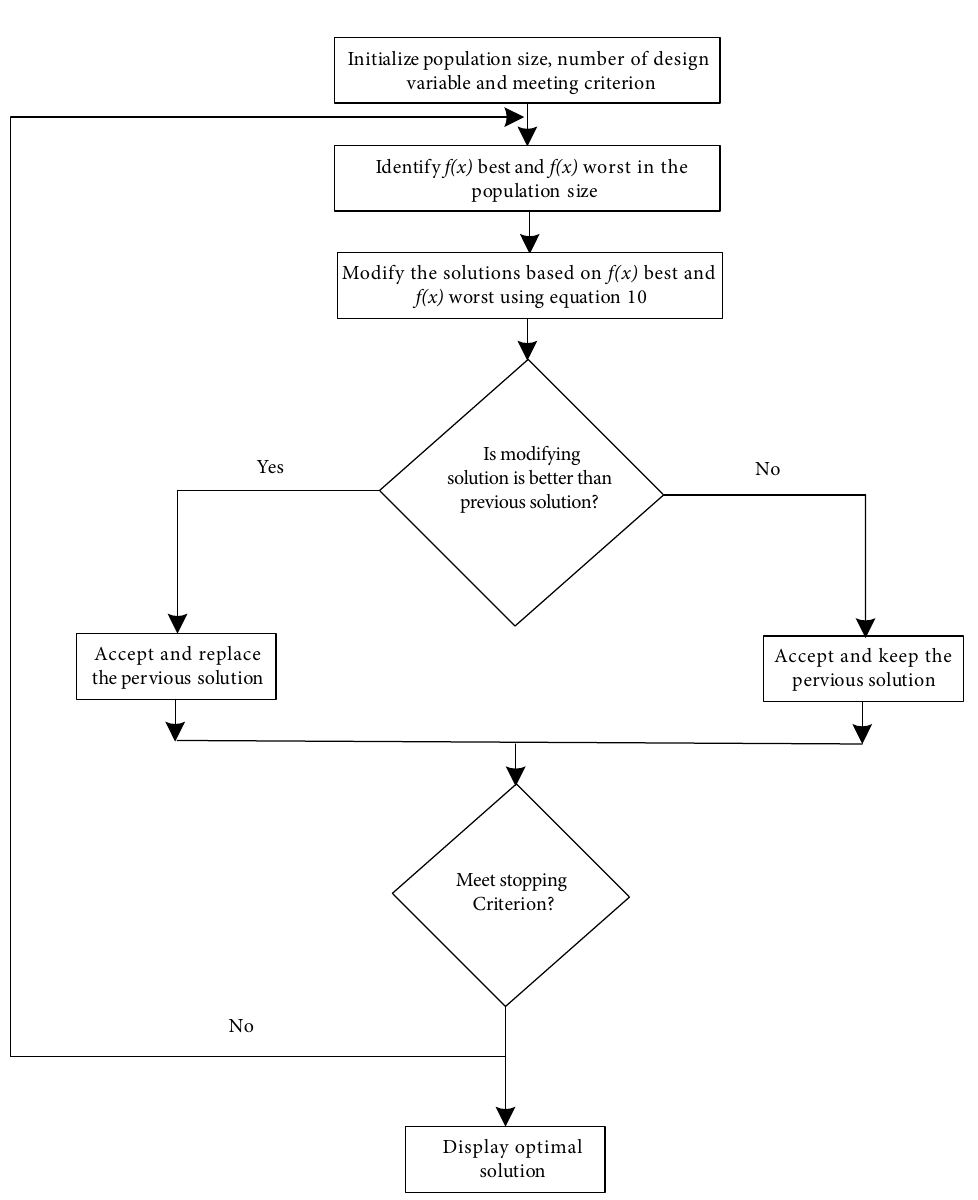
Figure 1: The flowchart of